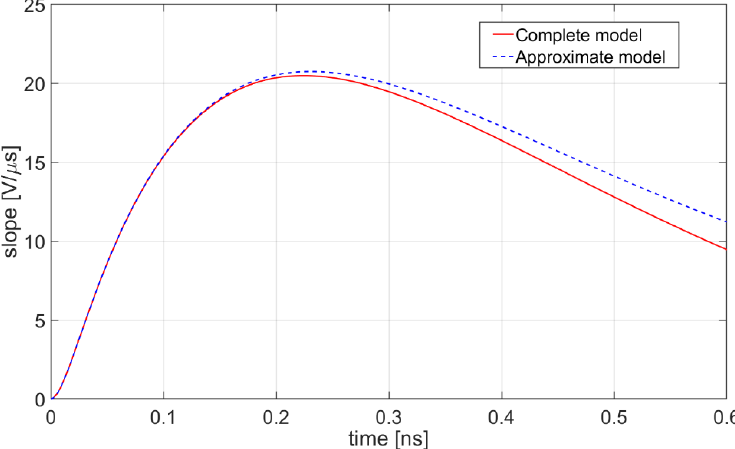
Figure 6. Time derivatives of the response V out (t): comparison between the complete model in Equation (9) and its approximation in Equation (11).